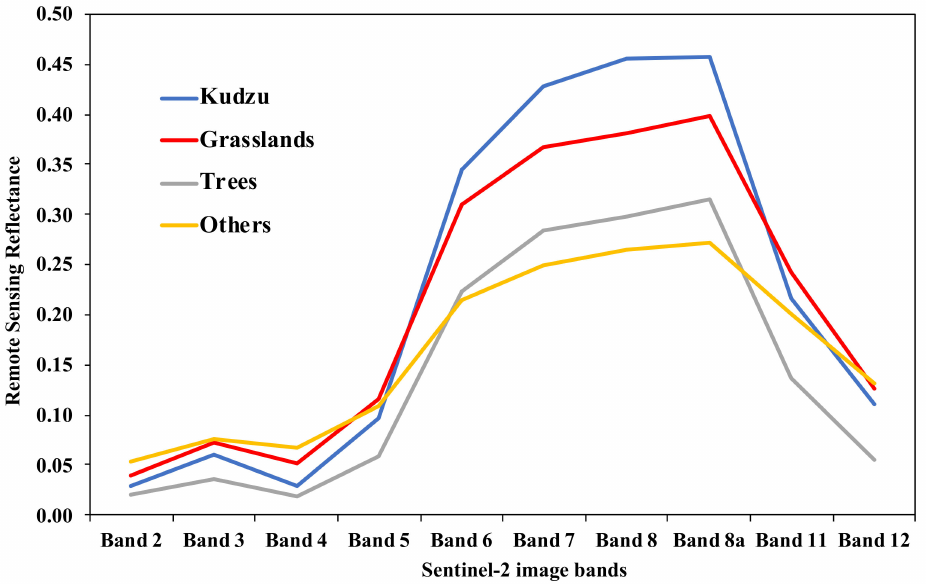
Figure 3. Remote sensing reflectance of the reference regions extracted from the fall Sentinel-2